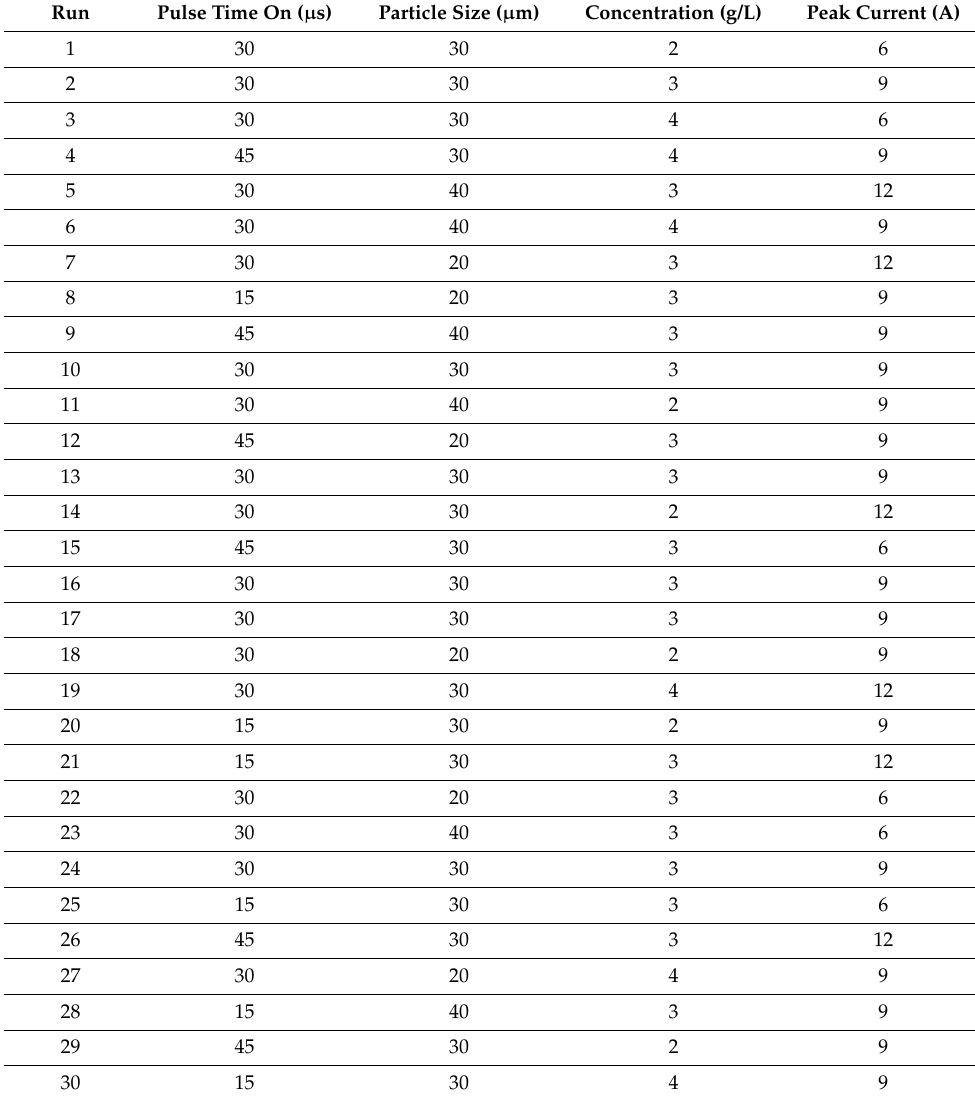
Table 4. Design of Experiments performed in the current